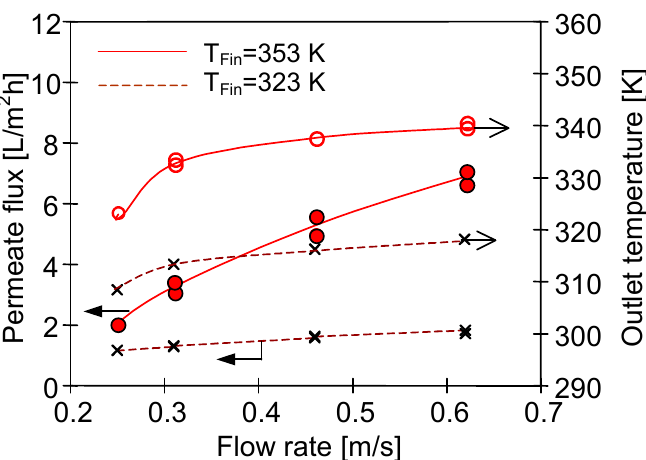
Figure 6. The influence of feed flow velocity on the permeate flux and feed outlet temperature for two different inlet temperatures (T Fin ). Mode 2—distillate temperature 293 K, feed inlet temperature 323 K or 353 K. Module SMD1.